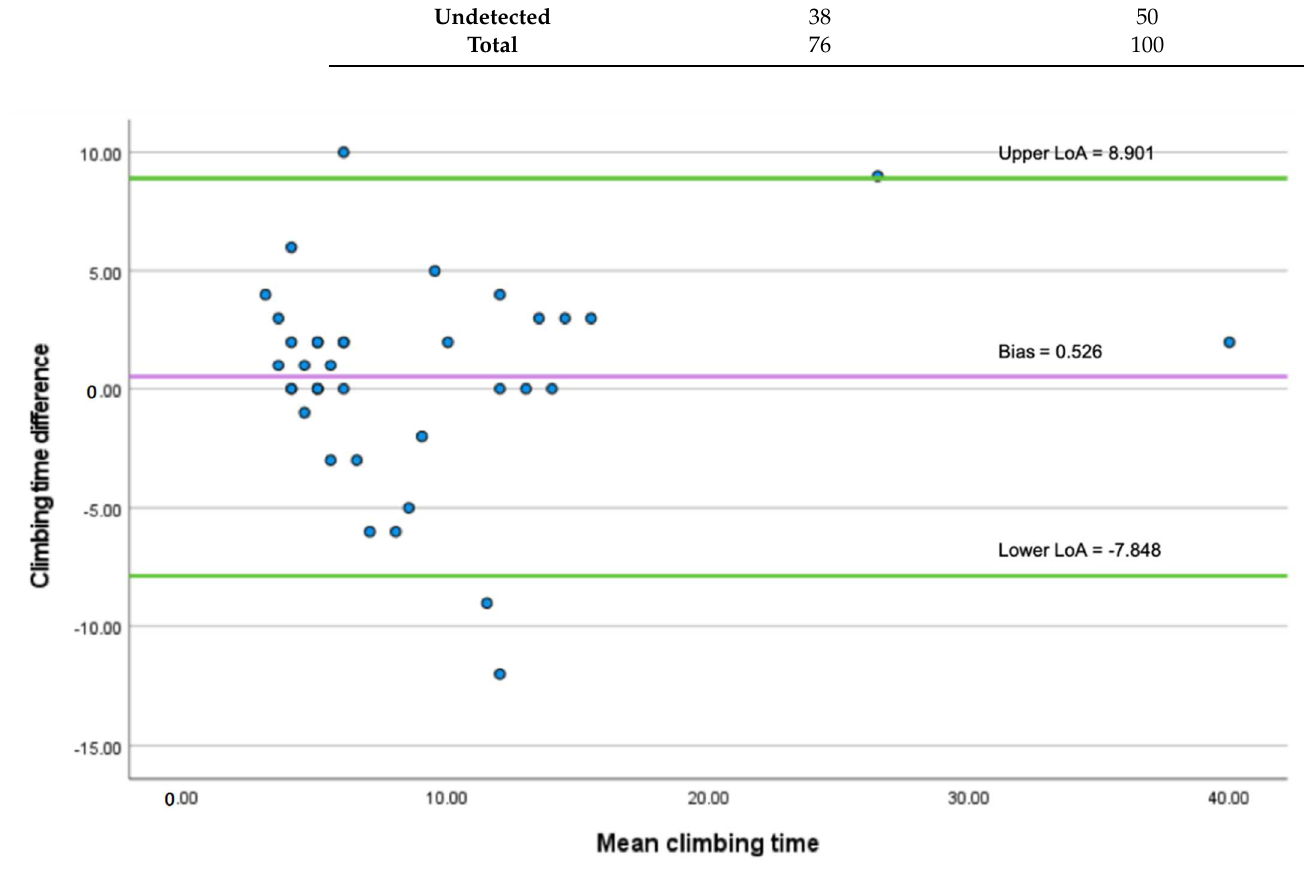
Figure 6. The Bland–Altman plot of agreement between distance sensor and video recording.